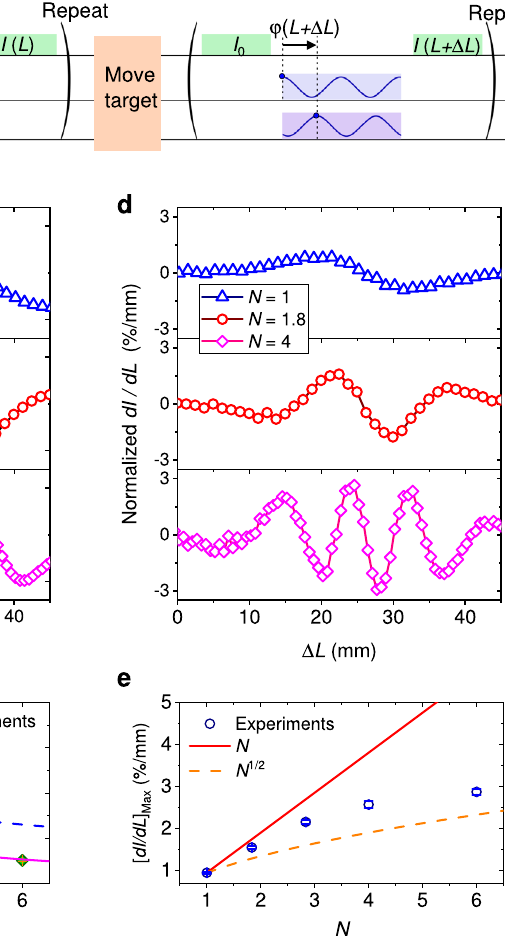
ffiffiffiffi p N linesrepresenttheestimationof1/ N and1 = ,respectively. d Theopticalresponse ofNVcenterensembletothetarget ’ spositionisdeducedfromthedatain( b ). e The ffiffiffiffi p N maximumopticalresponse dI / dL increaseswiththeRF π pulsenumberbeyond , due to the coherence of RF-spin interaction. The blue circles are experimental ffiffiffiffi p N results, while solid and dashed lines represent the estimation of N and , respectively.Thedataofopticalresponsein( d , e )havebeennormalizedby I 0 .Error bars in ( c , e ) represent the standard error of several